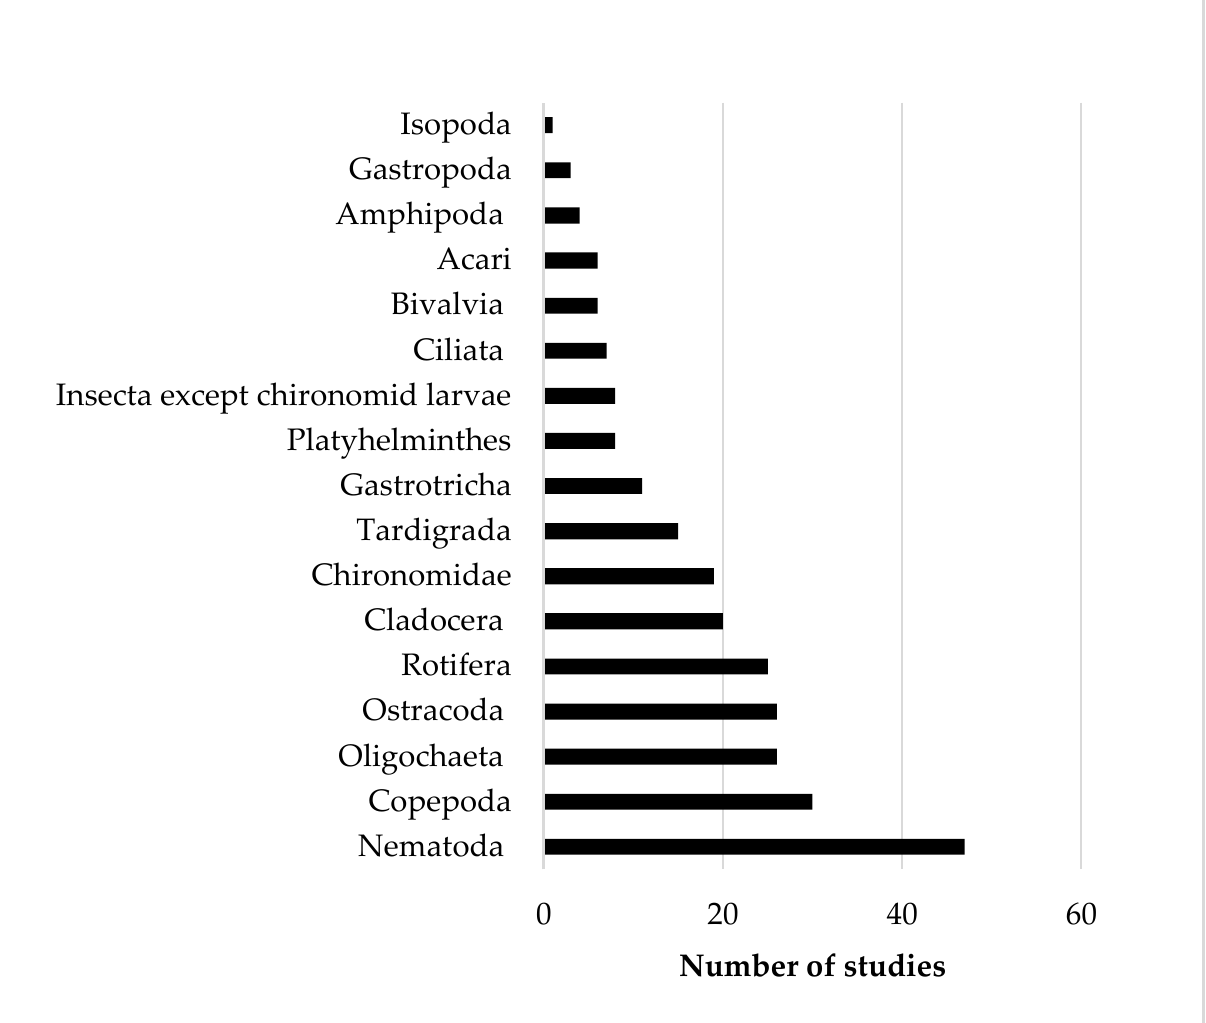
Figure 3. Number of taxonomy-based studies concerning the meiofaunal taxa of the littoral zone of freshwater lakes from 1995 to 2020.